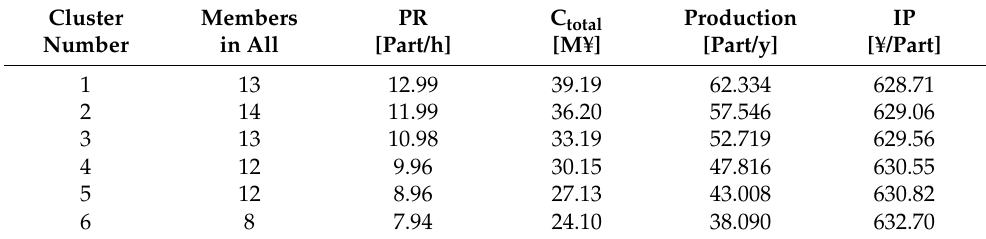
Table 4. Cluster analysis of the new approach (Case A).